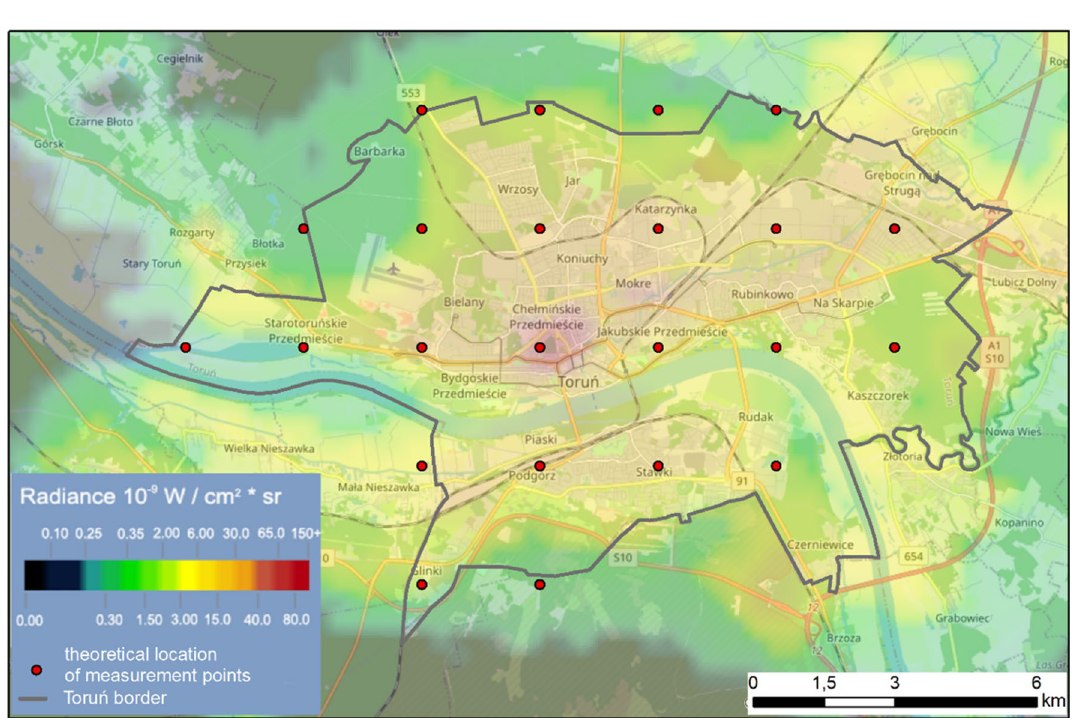
Figure 13. Theoretical location of measurement points. The background is the VIIRS light pollution map from 2021 at https:// www. light pollu tionm ap.